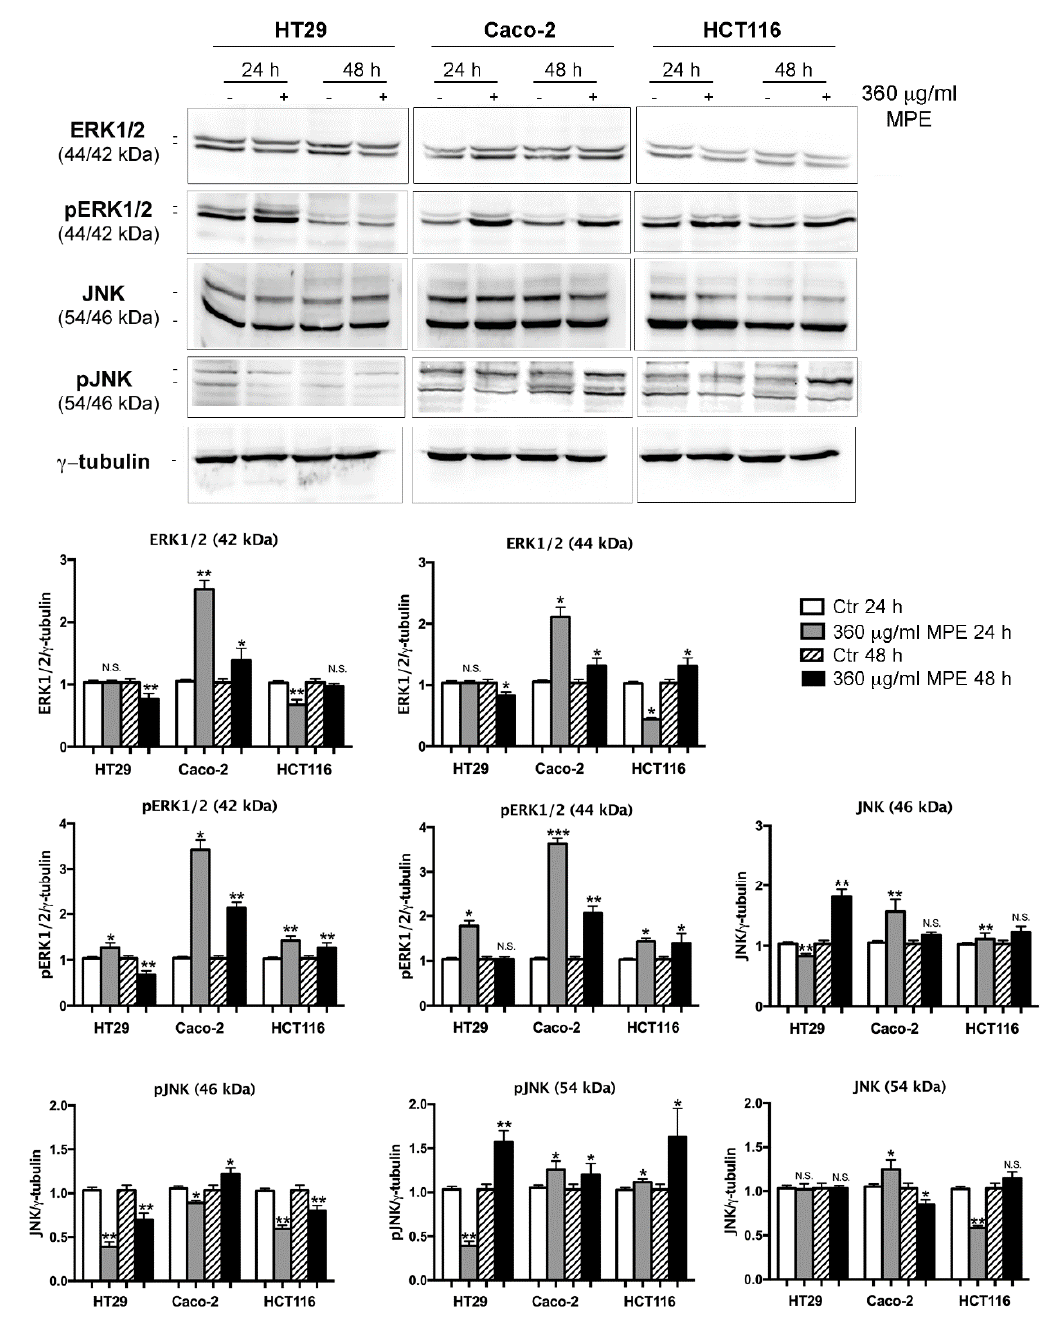
Figure 6. MPE treatment upregulates the main stress protein players pERK1 / 2 and pJNK. Colon cancer cells were treated with MPE for the indicated times, then Western blotting analyses of ERK1 / 2, pERK1 / 2, JNK and pJNK were performed, as reported in Materials and Methods section. Proteins were detected using specific antibodies. The correct protein loading was ascertained by immunoblotting for γ -tubulin. Representative blots of three independent experiments and densitometry analysis histograms are depicted. (*) p < 0.05, (**) p < 0.01 and (***) p < 0.001 compared to the untreated sample. N.S., not significant.